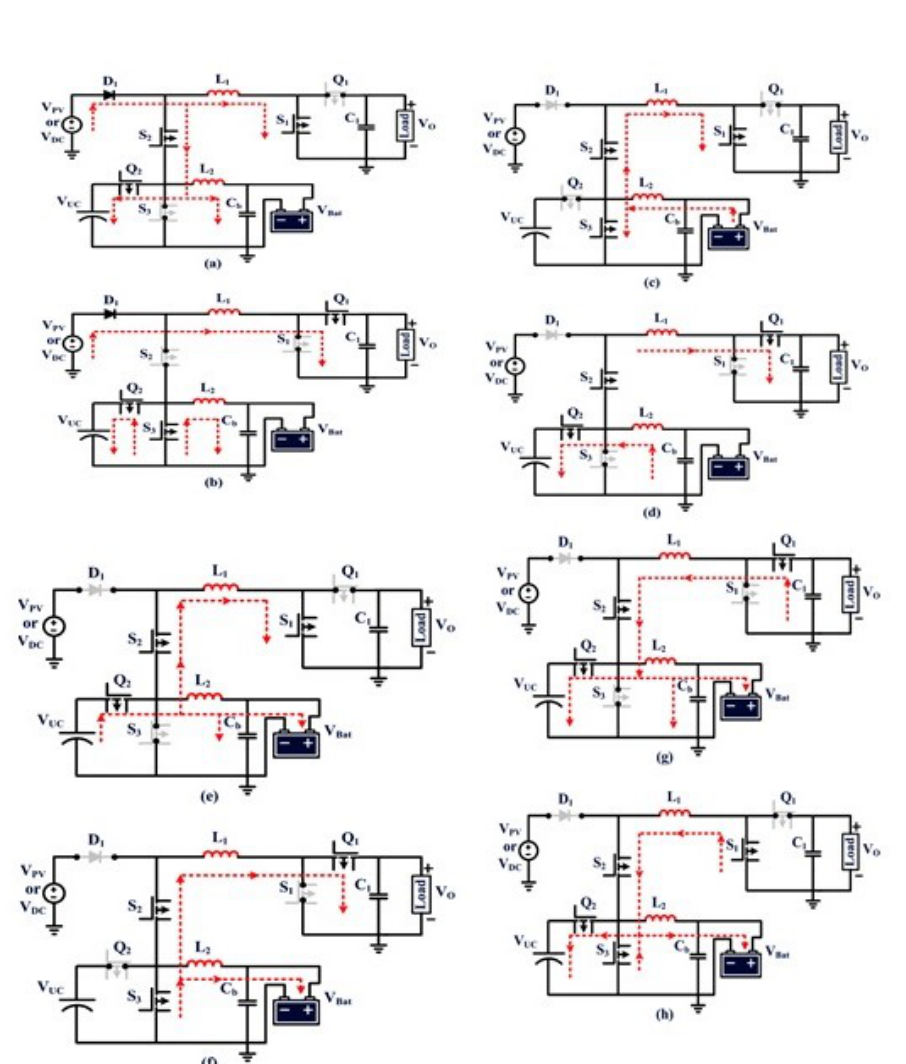
Fig. 3. Operation of FPB3C, (1) Case 1 [Mode (a) and Mode (b)], (2) Case 2 [Mode (c) and Mode (d)], (3) Case 3 [Mode (e) and Mode (f)],(4) Case 4 [Mode (g) and Mode